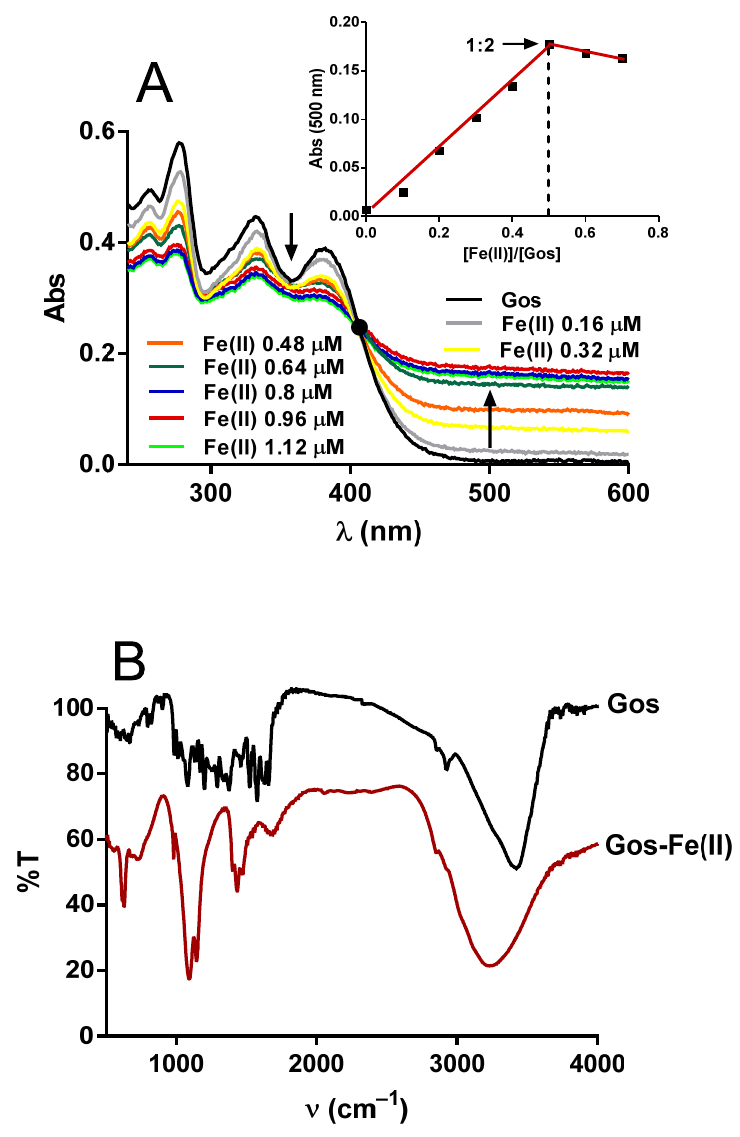
Figure 6. ( A ) Effects of Fe(II) on the Gos UV–VIS spectrum (200–600 nm). Incubation mixture containing 125 mM sucrose, 65 mM KCl, 10 mM HEPES buffer (pH 7.2), 2 mM citrate, and Gos 1.6 µM. The concentrations of Fe(II) from top to bottom traces were 0, 0.16, 0.32, 0.48, 0.64, 0.8, 0.96, and 1.12 µM. Inset: Job’s plot for the Gos-Fe(II) complex at a constant total concentration [Fe(II)] + [Gos] = 1.6 µM. Black dot indicates the isosbestic point. The downward and upward arrows indicate decrease and increase in absorbance values at 380 and 500 nm, respectively. Experiments were conducted at 28 °C. Scan speed was 2 nm/s. A baseline was established with the incubation mixture plus 1.6 µM Fe(II). ( B ) Infrared spectra of Gos and Gos-Fe(II). Typical examples are shown.